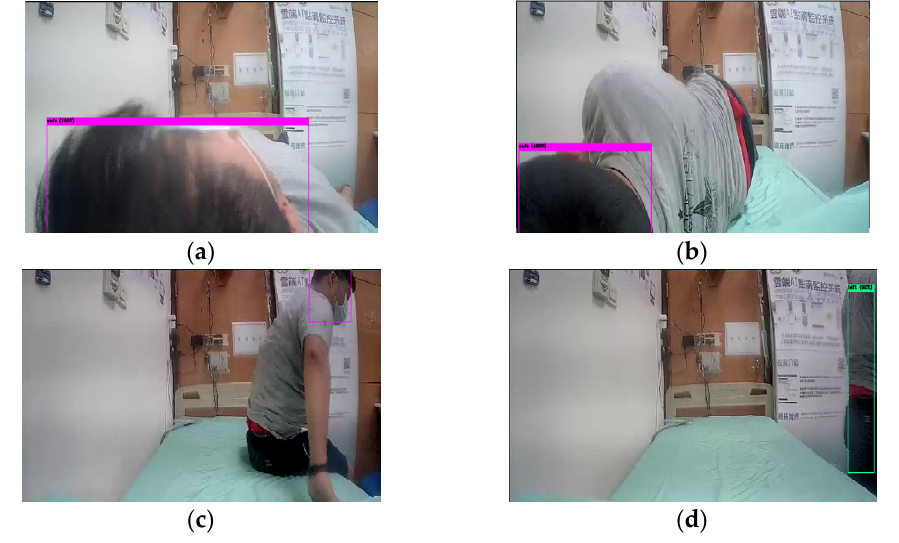
Figure 5. Object detection with bounding box in pink ( a – c ) and green ( d